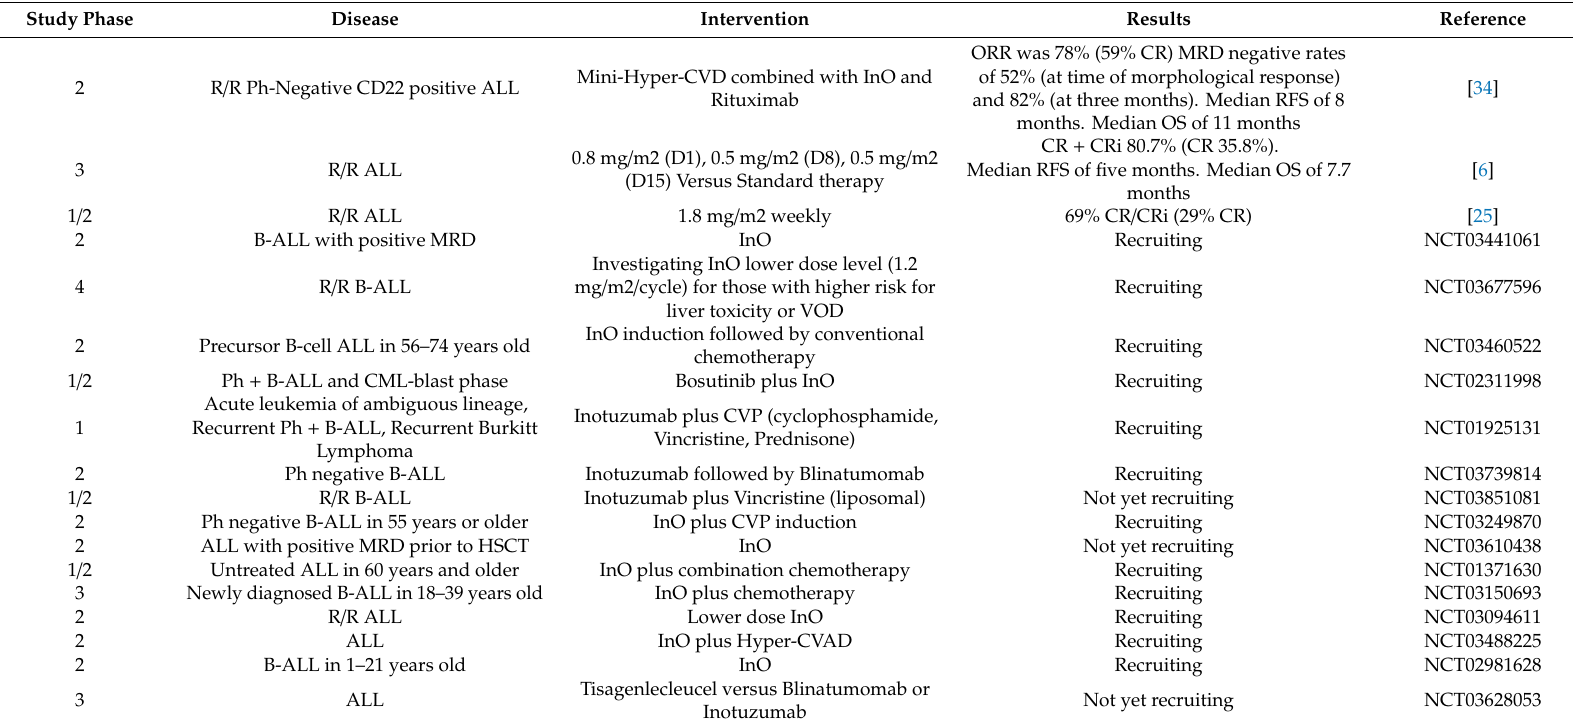
Table 1. Clinical trials of inotuzumab ozogamicin (InO) in B-ALL.